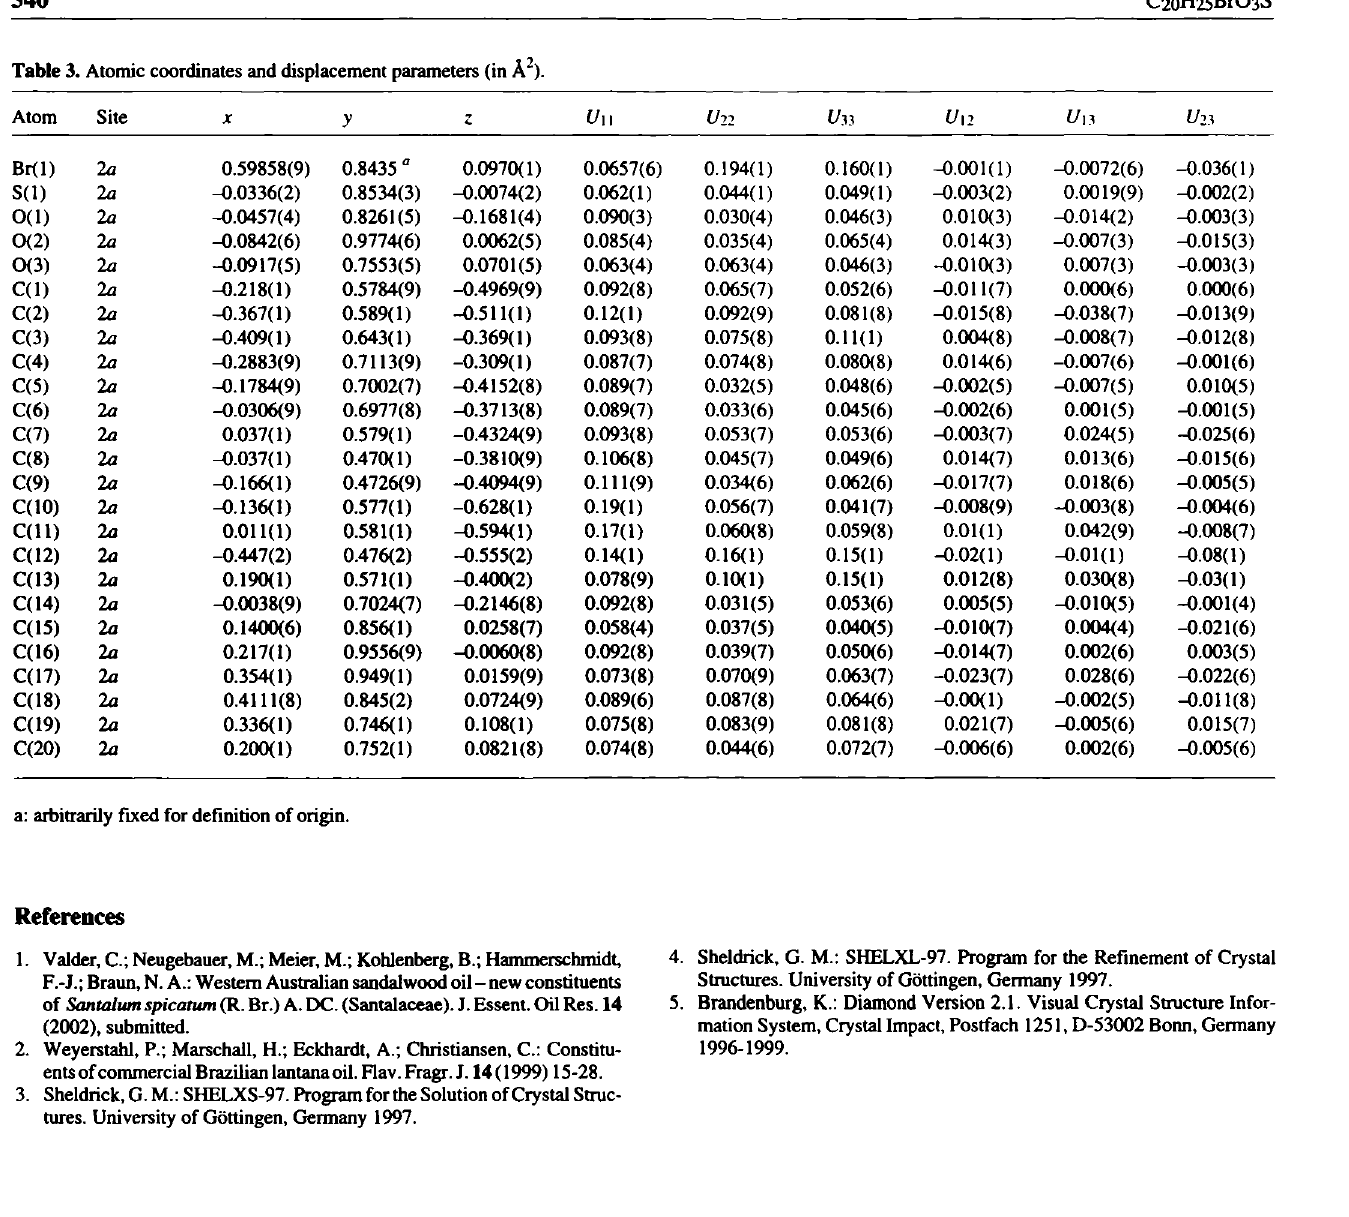
Table 3. Atomic coordinates and displacement parameters (in Â 2